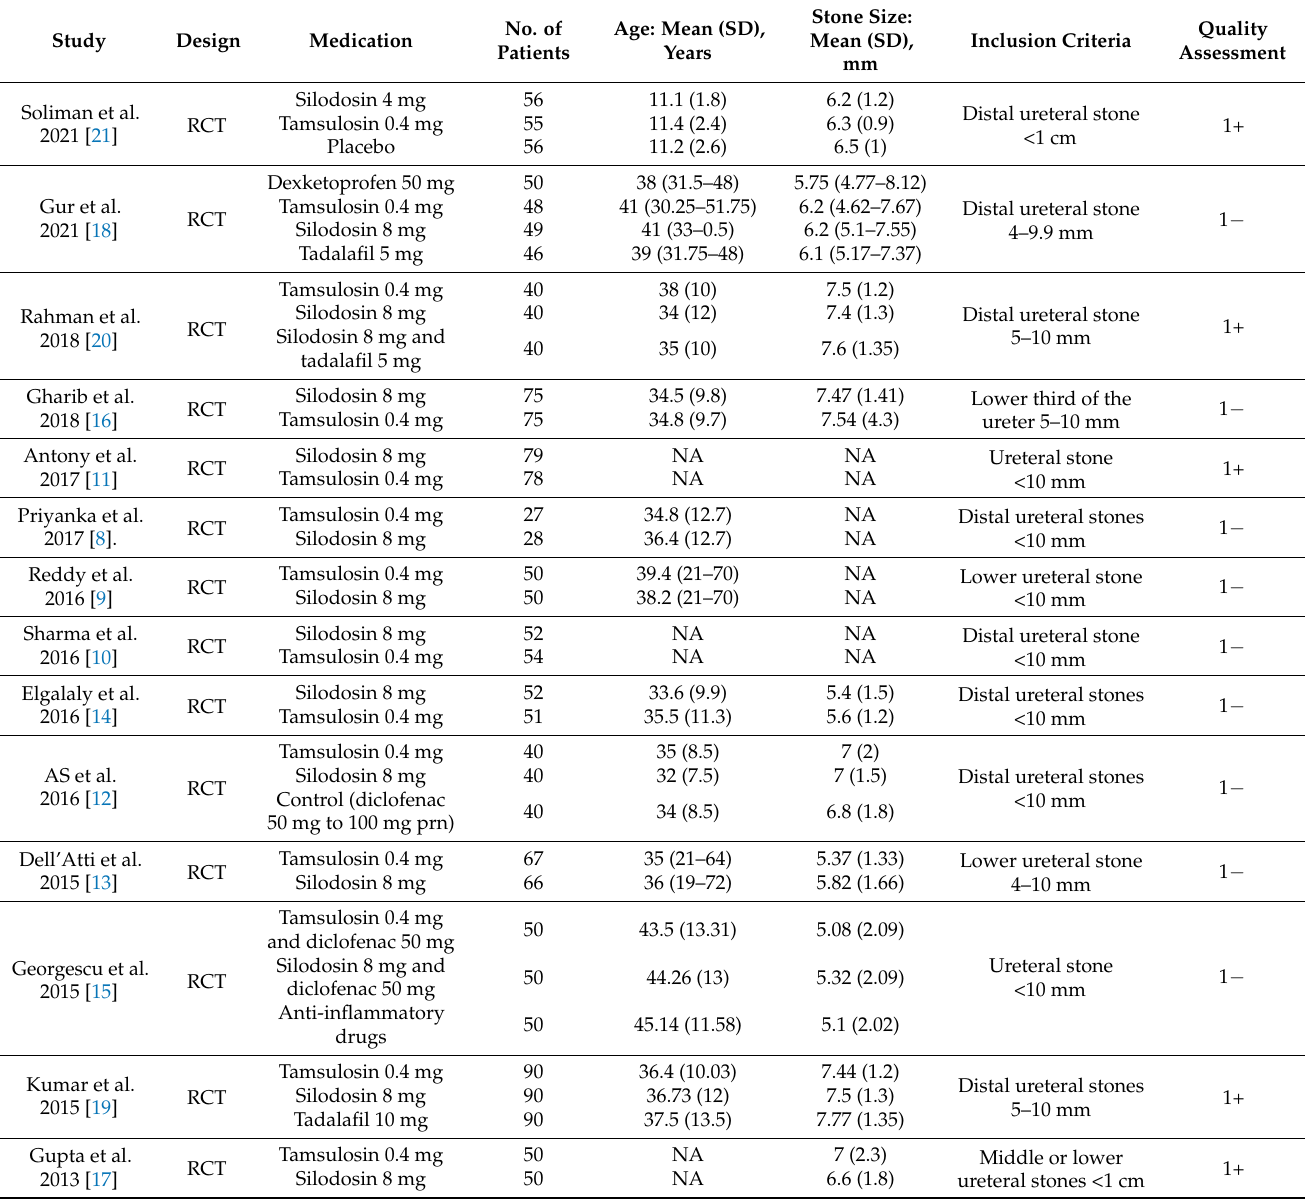
Table 1. Characteristics of included